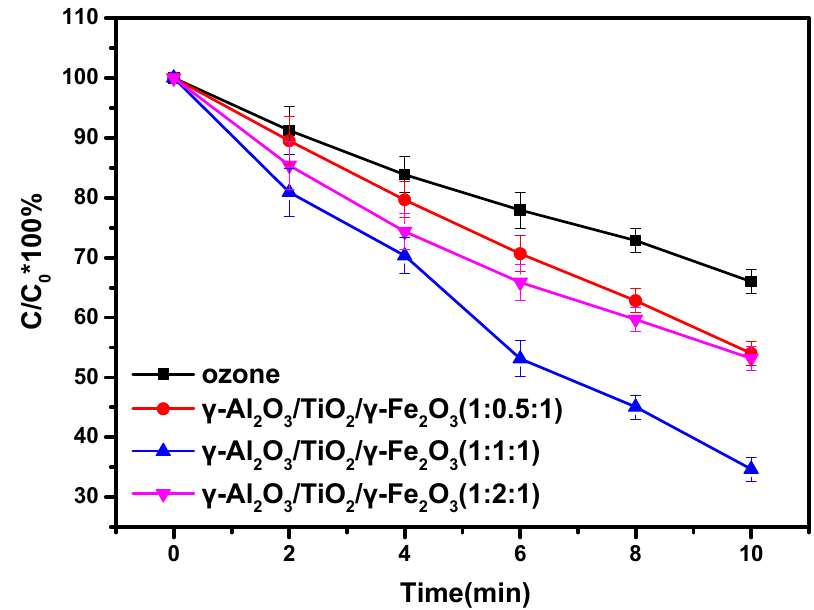
Figure 5. Degradation of ibuprofen by magnetic γ -Al 2 O 3 -based ozone catalyst.